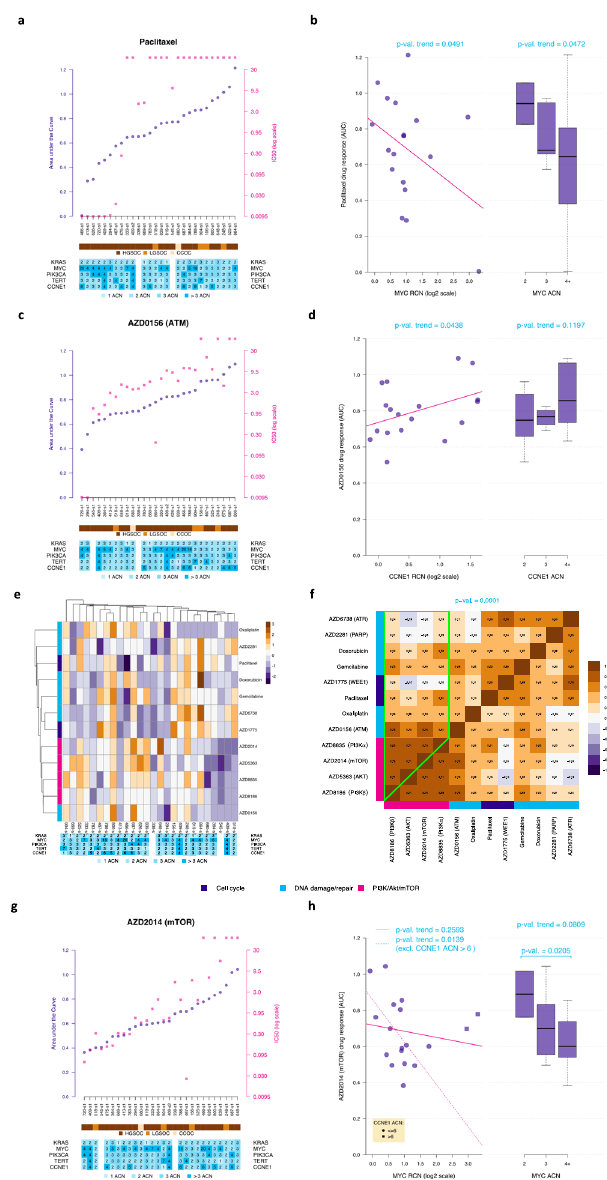
to mirror the distribution of clonal SCNAs (Fig. 2e and Supplementary Fig. S1b) as previouslydescribed inother tumours 6 . The distribution of focal clonal changes (e.g. gains or ampli fi cations in 3q and 8q; Fig. 2e) most frequently encompassed the HGSOC drivers PIK3CA and MYC , as well as TERT, KRAS and CCNE1 9 .